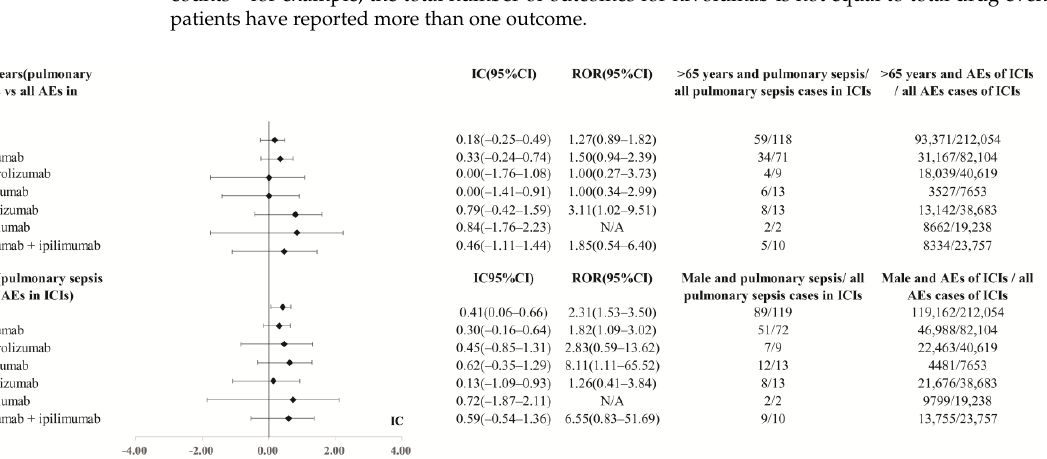
Figure 2. Age and gender distribution in pulmonary sepsis cases of ICIs. ROR, reporting odds ratio. IC, information component. 95%CI, 95% confidence interval. AEs, adverse events. ICIs, immune checkpoint inhibitors. N/A, not applicable. (Because the case number < 3, ROR could not be calcu- lated).